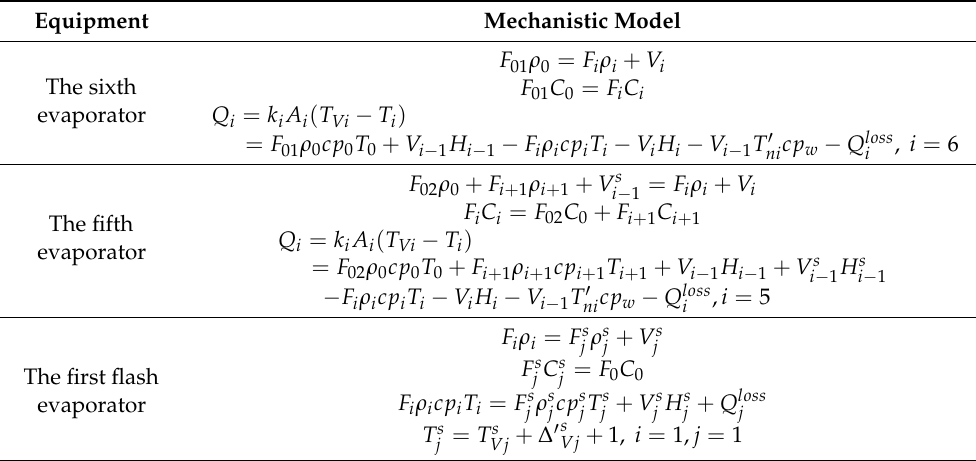
Table 1. The mechanistic models of the typical equipment.